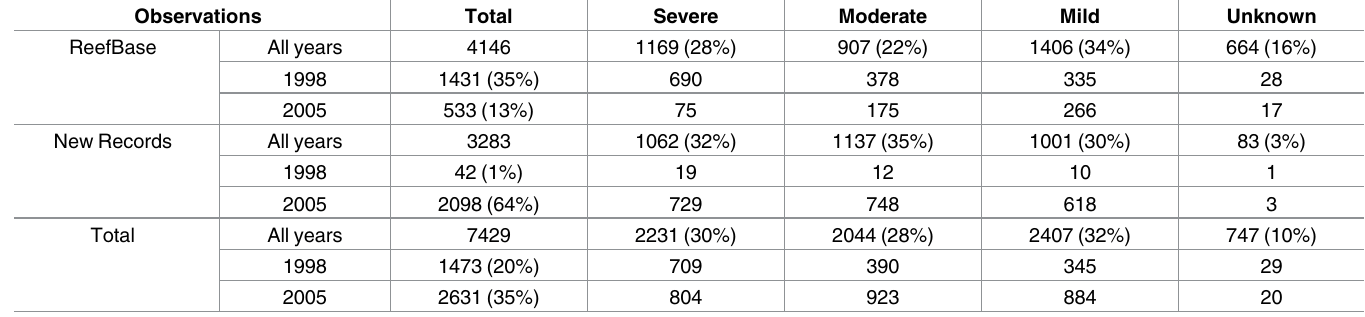
Table 3. Summaryof observational bleaching